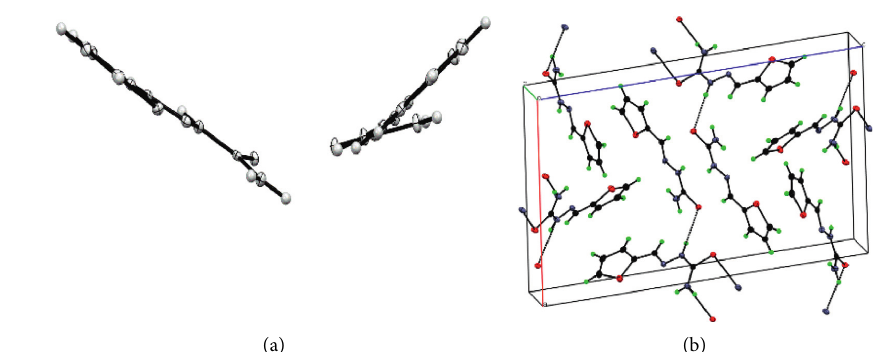
Figure 7: (a) ORTEP view for the molecular pair for ligand L1 showing the torsion in one molecule; (b) the crystal packing and